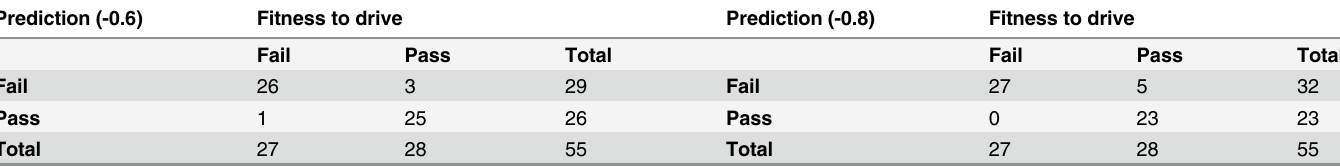
Table 6. Predictive accuracy of the final predictor variable with cut-off -0.6 (left) and -0.8 (right). Prediction